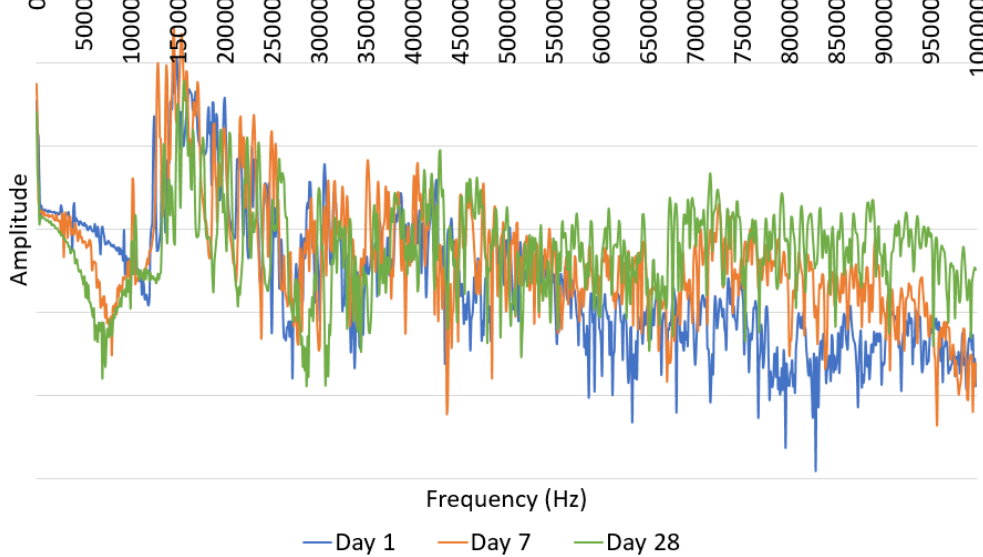
Figure 4. Power spectrums generated from P-wave analysis on S0 concrete cube specimen.